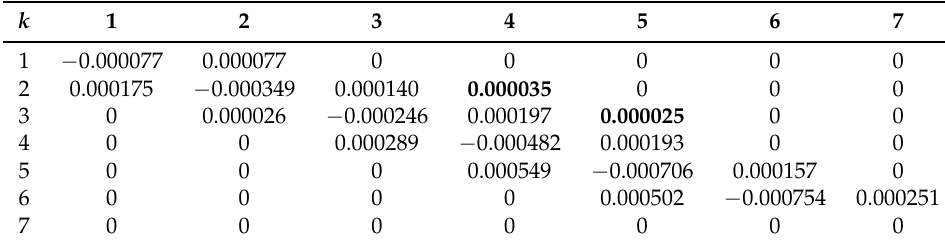
Table 1. Generator matrix—Moody’s.